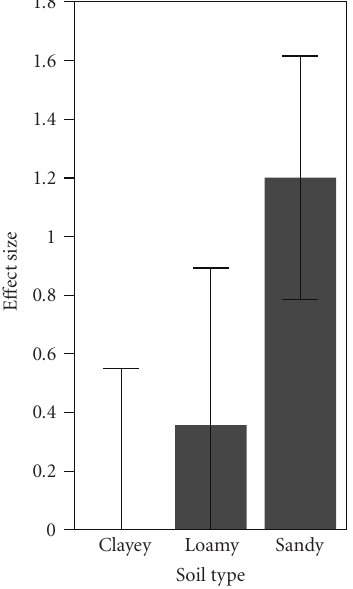
Figure 1: E ff ect size of earthworm e ff ects on plant growth based on results of 25 experiments presented in Table 1. Mean e ff ect size calculated as [ M 1 − M 2]/ σ with M 1: mean plant biomass in the presence of earthworms, M 2: mean plant biomass without earthworm, and σ : standard deviation without earthworm. P = . 02